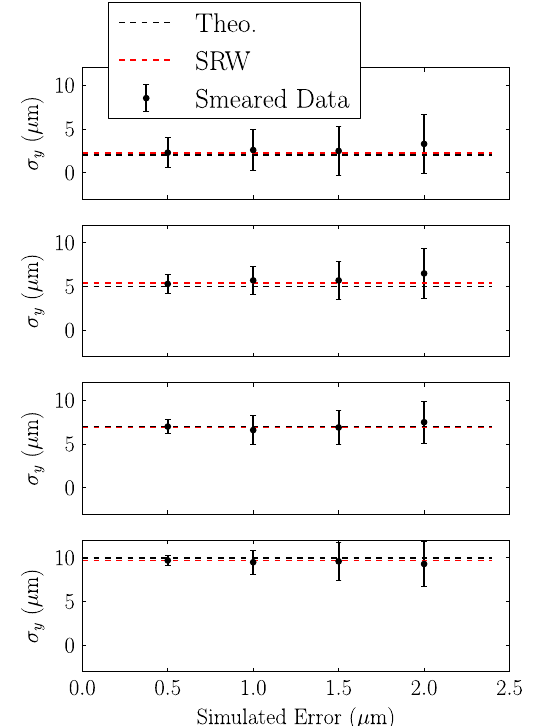
TUPB049.FIG. 15. Results for 2 μ m, 5 μ m, 7 μ m, and 10 μ m beam size reconstruction for SRI beam size measurement statistical errors of 0 . 5 μ m, 1 μ m, 1 . 5 μ m, and 2 μ m. Black dots are the obtained values, the error bar is given by the standard deviation of 100 smeared reconstructions, the black dashed line is the theoretical value, while the red dashed line is the result obtained performing rotating SRI SRW